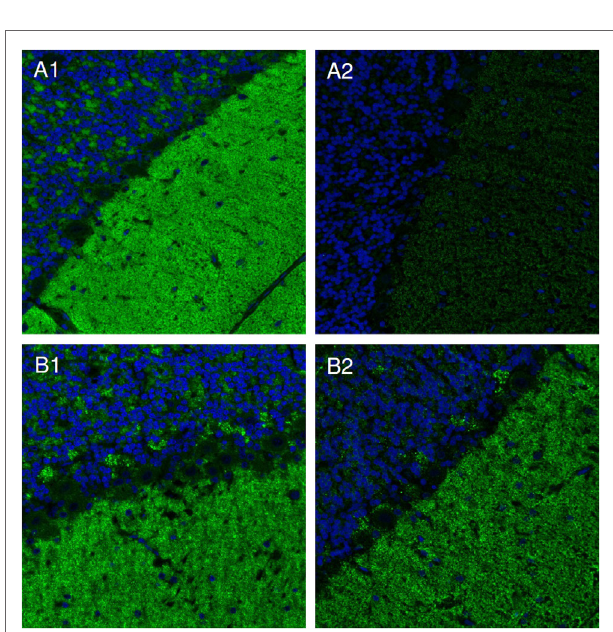
FigUre 2 | Immunocomplex extraction. Slides with cerebellum cryosections were incubated with patients’ sera and subsequently with either extraction [100 mmol/L Tris–HCl pH 7.4, 150 mmol/L sodium chloride, 2.5 mmol/L ethylenediamine tetraacetic acid, 0.5% (w/v) deoxycholate, 1% (w/v) Triton X-100] (a2,B2) , or detergent-free control buffer (a1,B1) . Bound IgG was visualized by Alexa488-labeled goat anti-human IgG. Nuclei were counterstained by incubation with TO-PRO-3 iodide (blue). Examples of soluble (a) and insoluble (B) immunocomplexes are shown.